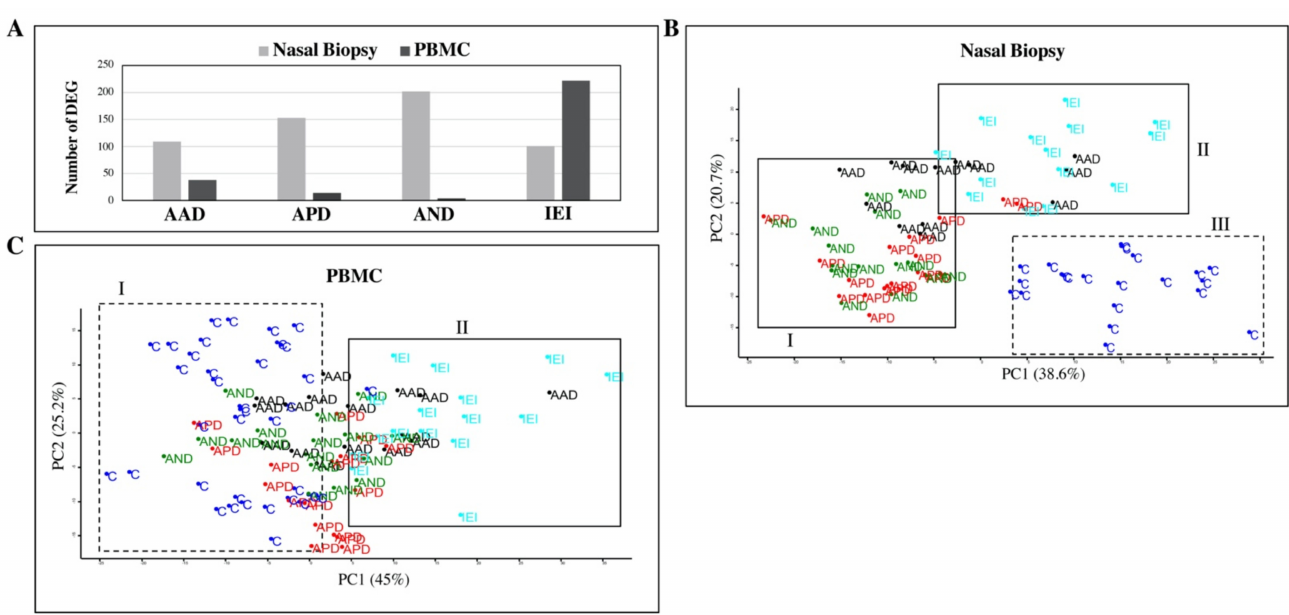
Figure 2. Comparison of differentially expressed genes (DEGs) identified in patient versus controls ( A ). Patient groups with asthma that is associated to dampness and molds, possibly associated to dampness and molds, and not associated with dampness and molds are denoted as AAD, APD, and AND, respectively. Patients diagnosed with idiopathic environmental intolerance are denoted as IEI, and controls are denoted as ( C ). Principal component analysis (PCA) shows top two components represented by genes identified as differentially expressed in the nasal biopsies ( B ) and blood cells (PBMCs) ( C ) of patients versus controls. In the nasal biopsies ( B ), the top 2 components of the PCA plot separated all samples into three main clusters. Cluster I consisted of all AND patients, 90% of all APD patients, and 50% of all AAD patients. Cluster II consisted of all IEI patients and a couple of APD and half of all AAD patients. All control samples grouped together in Cluster III. In blood cells ( C ), clearly distinct asthma patient or control subgroup clusters cannot be identified from the top 2 components of the PCA plot. However, the control samples (Cluster I) do cluster separately from IEI individuals (Cluster